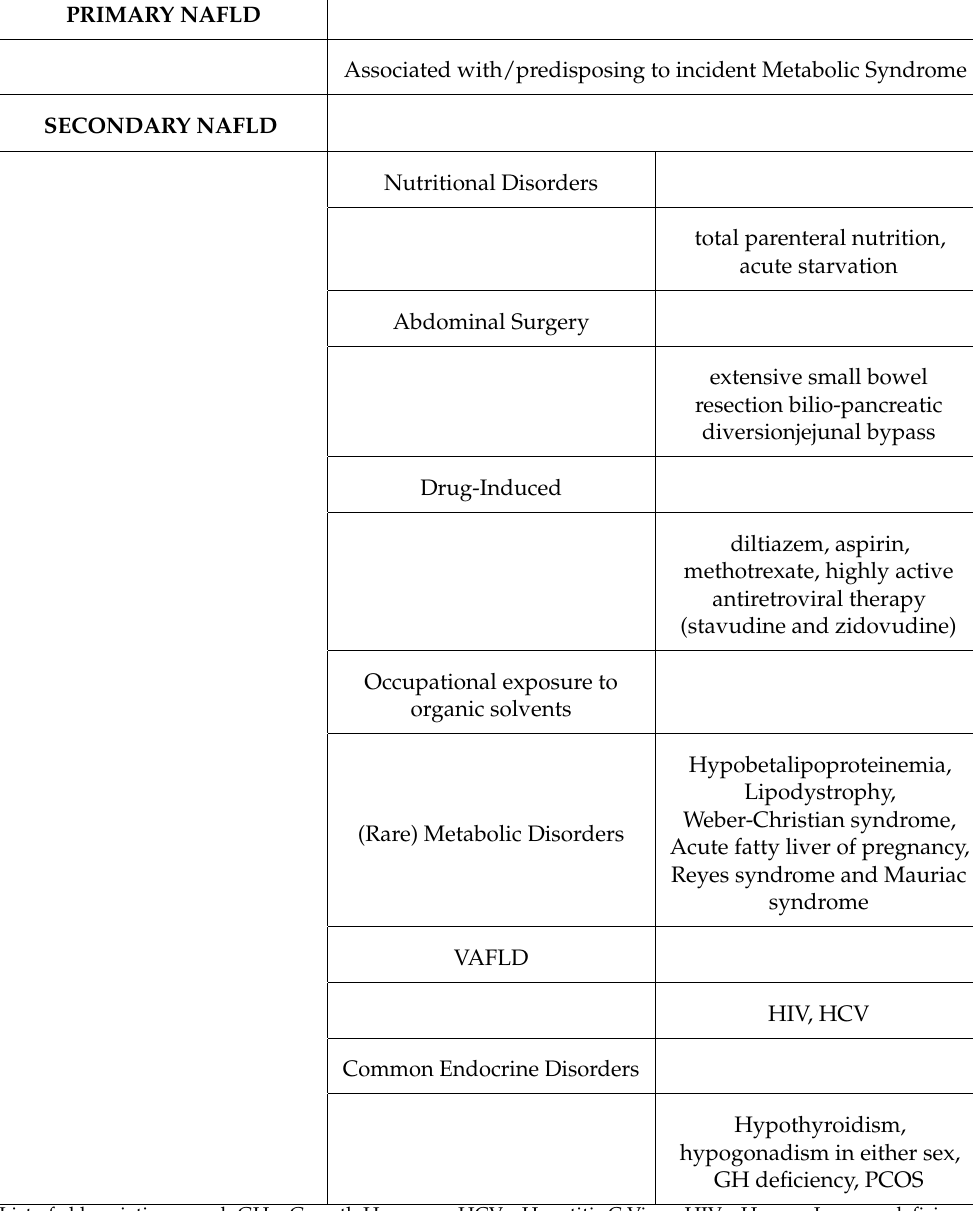
Table 1. Classification of NAFLD